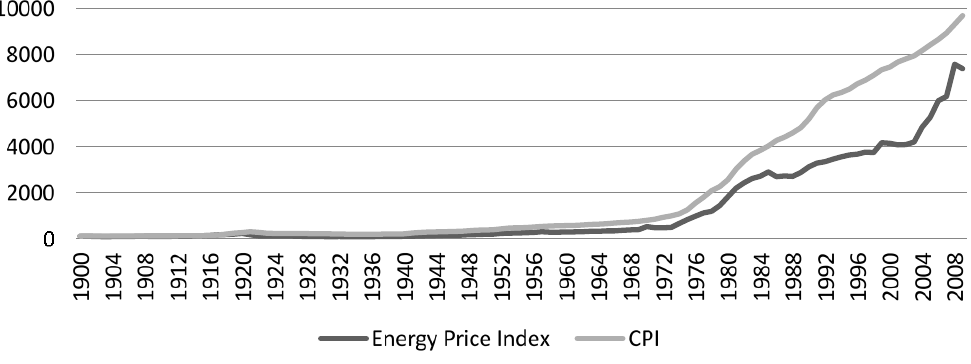
Figure 7. Development of CPI and EPI in Britain between 1900 and 2009 (1900 = 100).